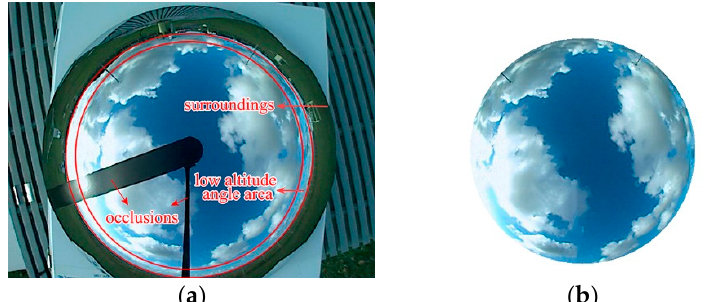
Figure 2. Redundancy in the image and the pre-processing result: ( a ) Redundancy in the image; ( b ) the preprocessing result.